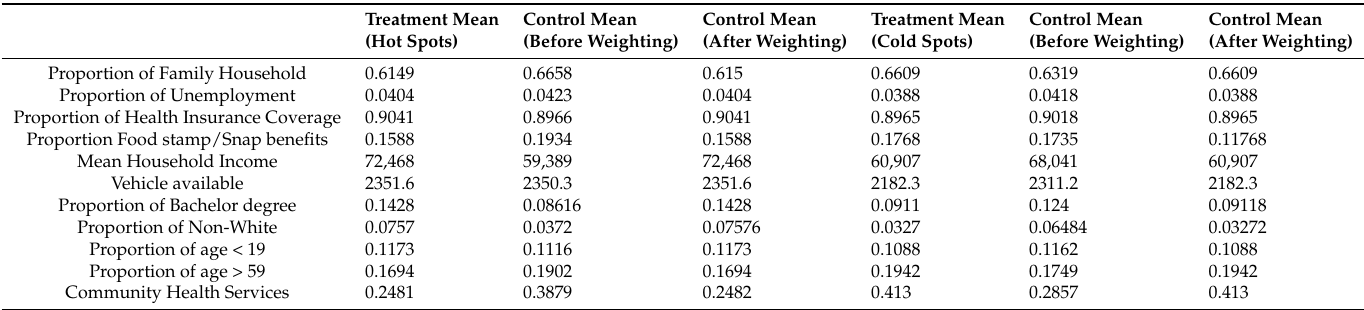
Table A2. Covariate